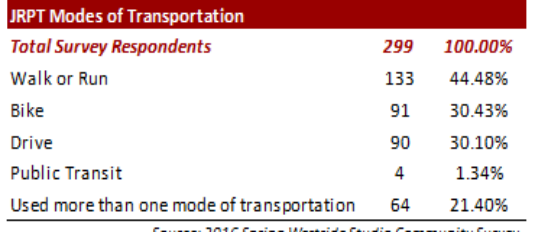
Figure 5. Mode split to access North Temple. source: created by authors for this paper. From this information it can be concluded that respondents are already using active modes of transportation along the two corridors. However, there seems to be room for increasing active transportation users not only along the JRPT, but also along North Temple. With the possibility to increase active transportation usership, potential barriers need to be studied. Perhaps there are reasons why residents are choosing to forego biking or walking along these two corridors. Over one-third of the respondents (101 of 299) indicated that there is not much to walk or bike to. This supports our idea of destinations being a draw for active transportation users. 9. Discussion and Conclusions North Temple is clearly a corridor meant for transit-oriented development (TOD) because of the variety of transportation options available. Including a mixture of developments, such as housing, office, and retail into a neighborhood makes a place more walkable, especially when access to transit is within a half-mile. A secondary goal of TODs is to create a hub of commercial conveniences provided by small- and medium-sized businesses [12]. In contrast to North Temple, the JRPT is primarily recreational in nature. Given the land uses, mostly residential, surrounding most of the JRPT, with the exception where it connects to North Temple it is not likely that most residents will use the trail for non-recreational purposes such as work and shopping. The population density along the trail is low and it currently does not support additional commercial spaces. In order to increase demand for the trail for non-recreational uses, greater density would need to be added in the form or more residential units and then an increased number of destinations that respond to that density (e.g., coffee shops, neighborhood supermarkets and the like). Right now, the area that connects between North Temple and the JRPT is being envision as a TSA node, so there are plans to add density and destinations in the area. Although the current survey results in the study do not support sufficient non-recreational demand for the JRPT right now,